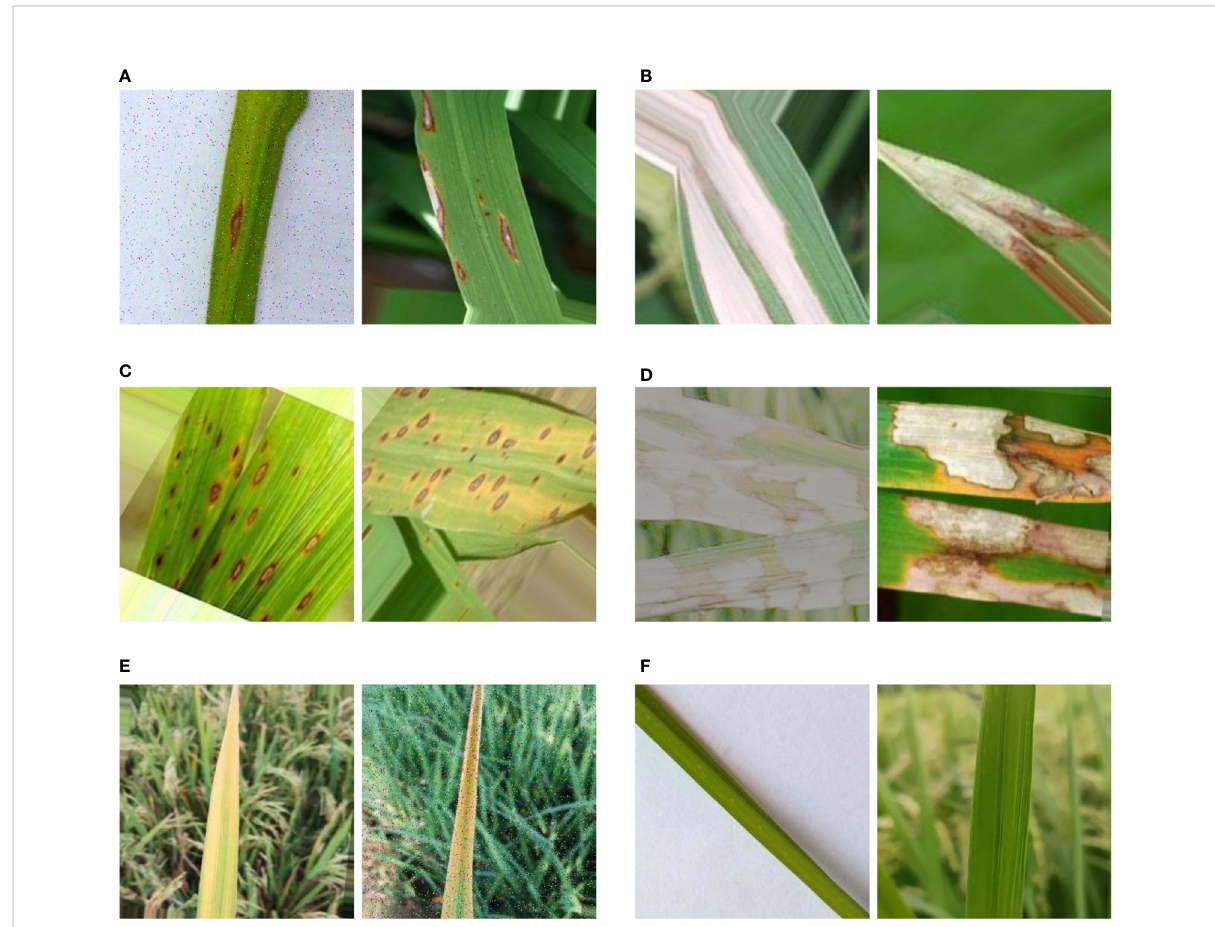
FIGURE 4 Rice leaf disease images. Note that (A) stands for rice blast, (B) stands for bacterial leaf blight, (C) stands for brown spot disease, (D) stands for sheath blight, (E) stands for tungro disease and (F) stands for